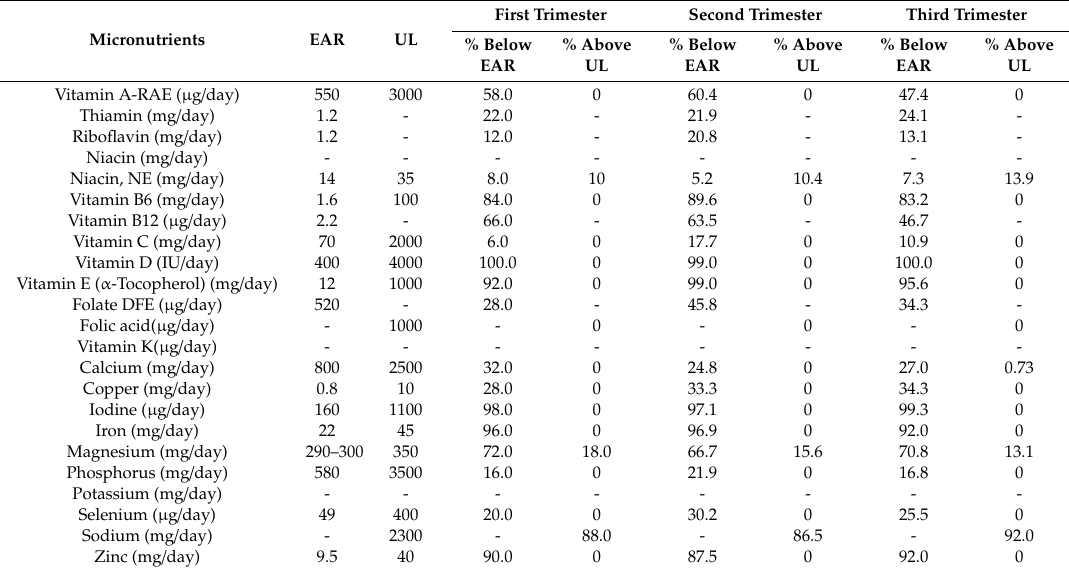
Table 5. The proportions of pregnant women that reported the micronutrient intakes from food alone below or above the corresponding dietary reference intakes.